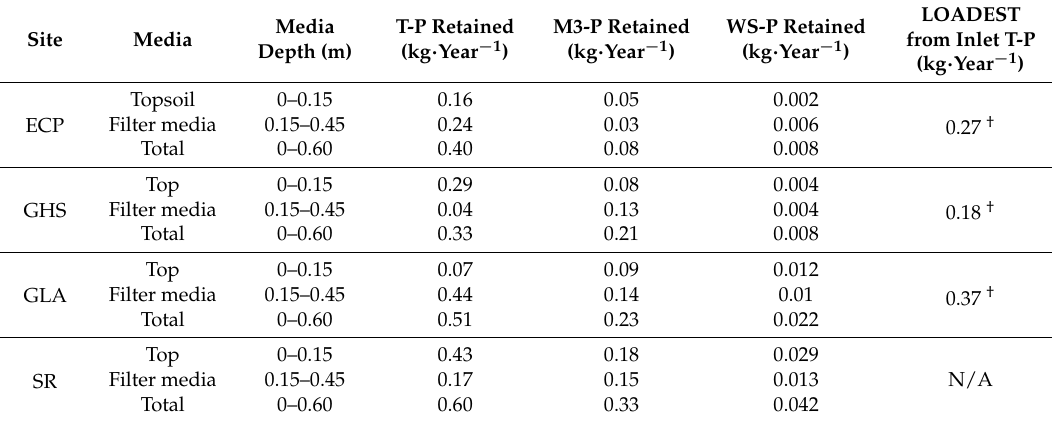
Table 6. Phosphorus retained within the bioretention media analyzed from three different extraction methods and inlet T-P load in three bioretention cells monitored estimated using LOADEST